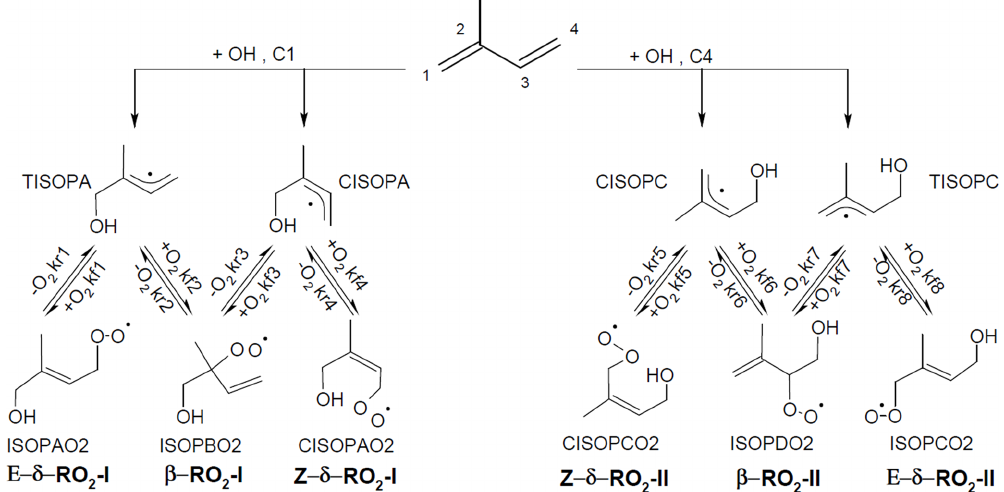
Figure 1. Schematic of the equilibrium reactions between OH-isoprene adducts and isoprene-RO 2 conformers, as well as their formation reactions. The names used for the different molecules are as in the MCMv3.3.1 (regular text) and in the LIM1 study (bold). The model- specific rate coefficients for each reaction are summarized in Table 1.